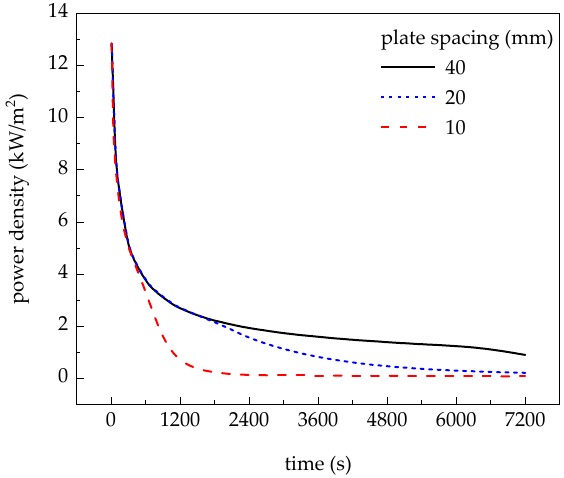
Figure 6. Effect of plate spacing on heat exchange power density of coil-plate unit.